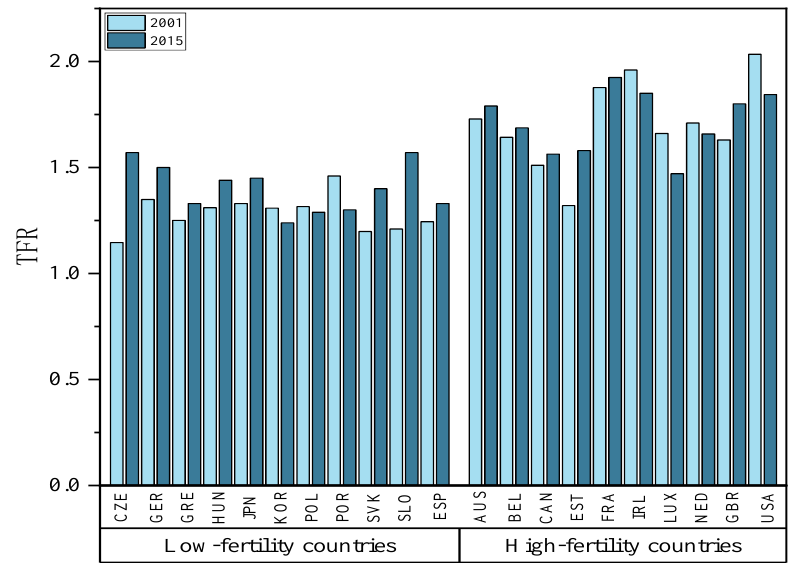
Figure 6. Total fertility rates in the selected OECD countries, 2001 and 2015.